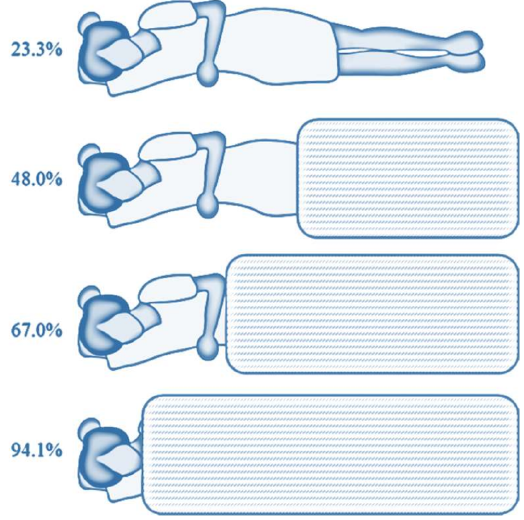
Figure 4. Coverage rates for patients in bed. Table 3. Clothing and activity scenarios for